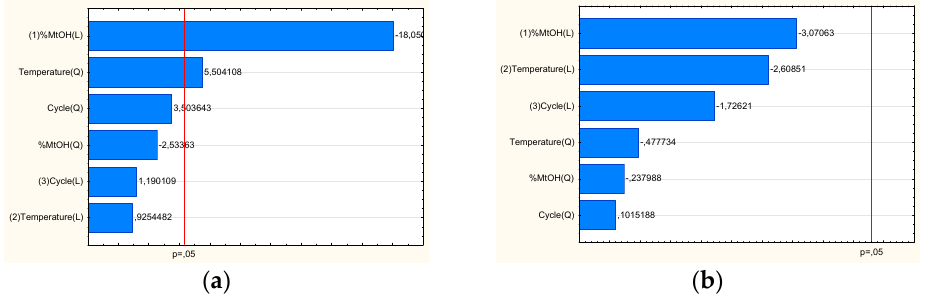
Figure 3. Pareto plot of standardized effects for the antioxidant activity using DPPH assay ( a ) and for anti-hyaluronidase activity ( b ).